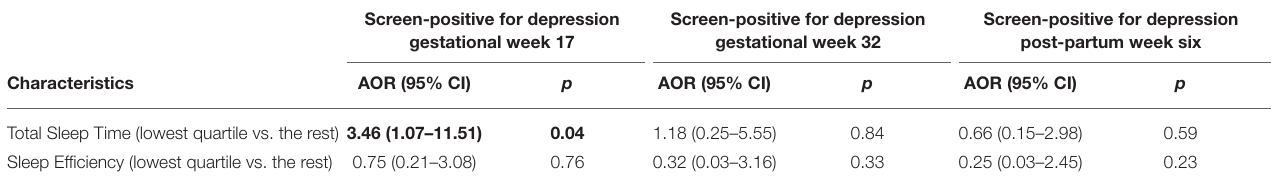
TABLE 3 | Multiple logistic regression analyses of the association between objectively assessed sleep parameters and being screen-positive for ongoing depression on the EPDS in gestational weeks 17, 32 and 6 weeks